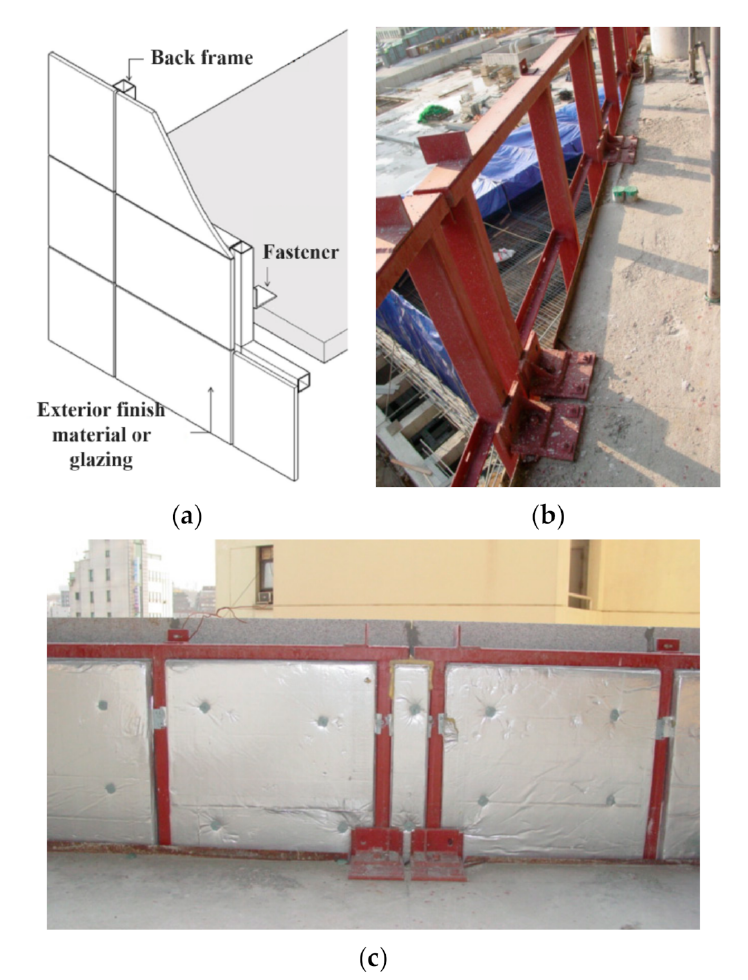
Figure 1. Configuration and example of back frame type curtain wall: ( a ) configuration [5,6]; ( b ) example of a back frame; ( c ) example of insulation